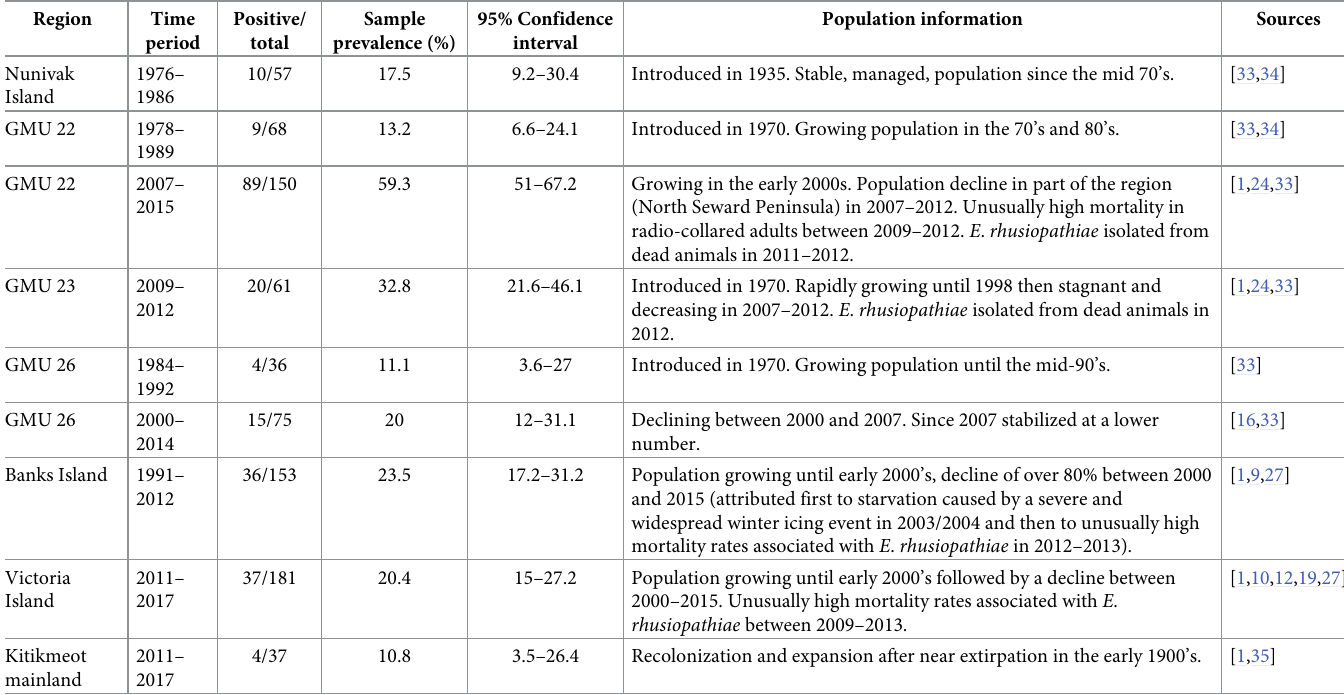
Table 1. Seroprevalences to Erysipelothrix rhusiopathiae in North American muskoxen.